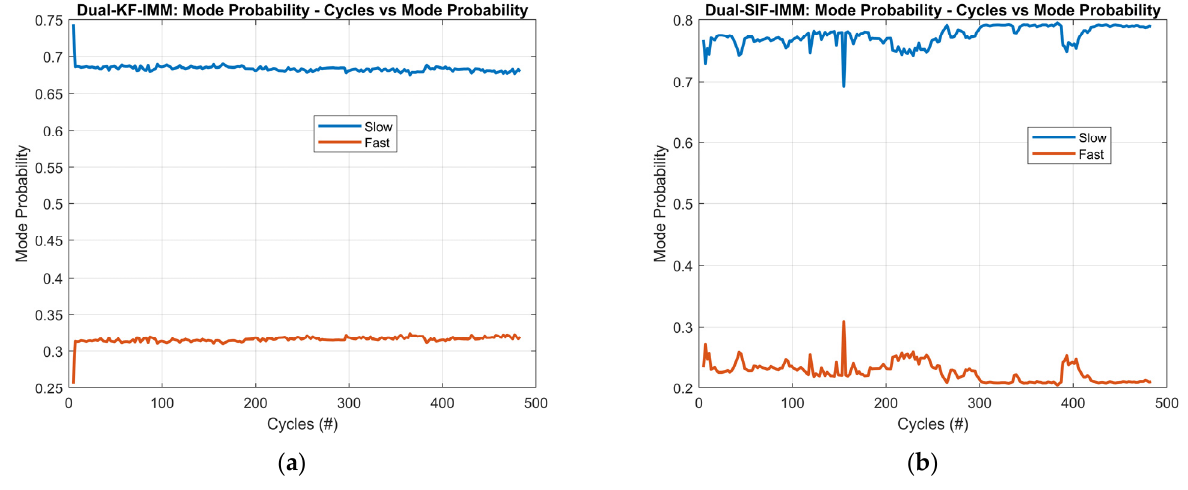
Figure 13. ( a ) Dual-KF-IMM mode probability. ( b ) Dual-SIF and dual-SIF-IMM mode probability.